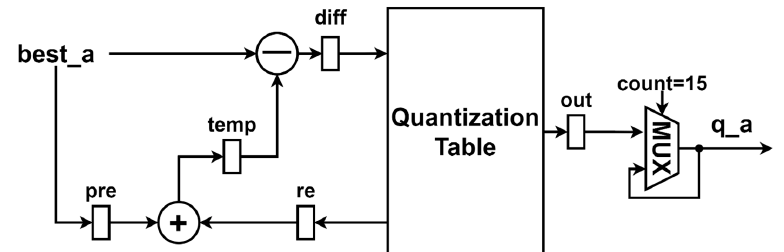
Figure 10. The architecture of the prediction module.